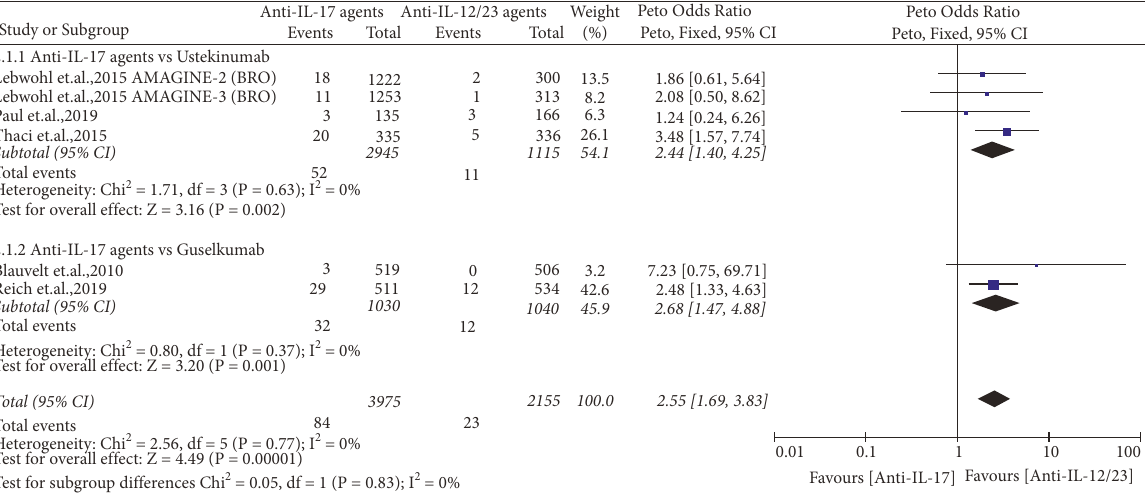
Figure 3: Forest plot of pooled data regarding Candida infections between anti-interleukin (IL)-17 agents and anti-IL-12/23 agents. CI, confidence interval.